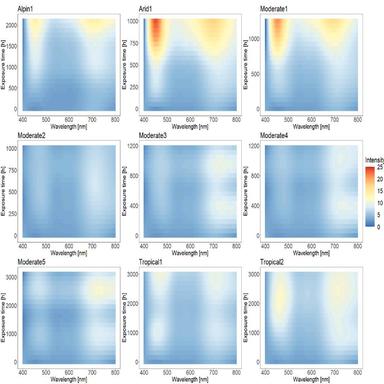
Heatmaps obtained from bivariate smoothing of the UV-F spectra recorded for the nine ageing actions.